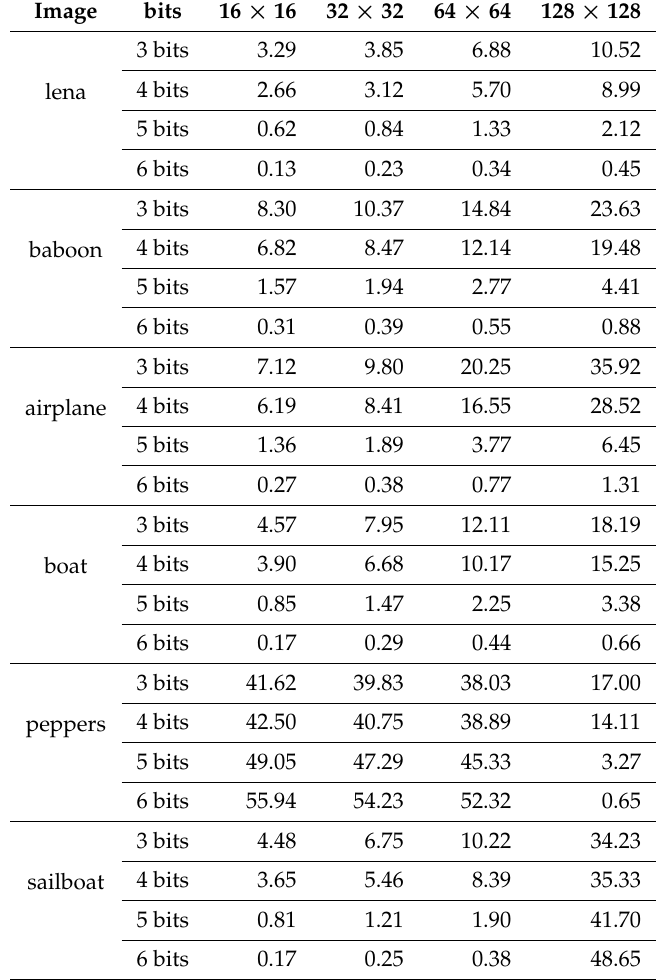
Table 1. The mean squared error (MSE) value on different images with different measurements. Image